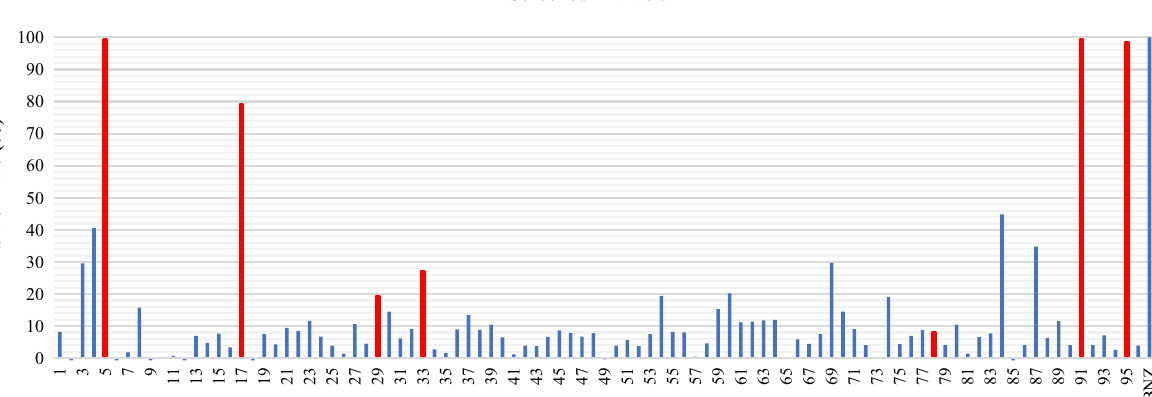
Fig. 2 Cytotoxicity screen of 120 kinds of extracts (20 μg/ml) and 94 kinds of compounds (20 μM) isolated from medicinal herbs with alamarBlue reagent. Data are presented as percent reduction in intensity, indicating cell viability. Experiments were done in